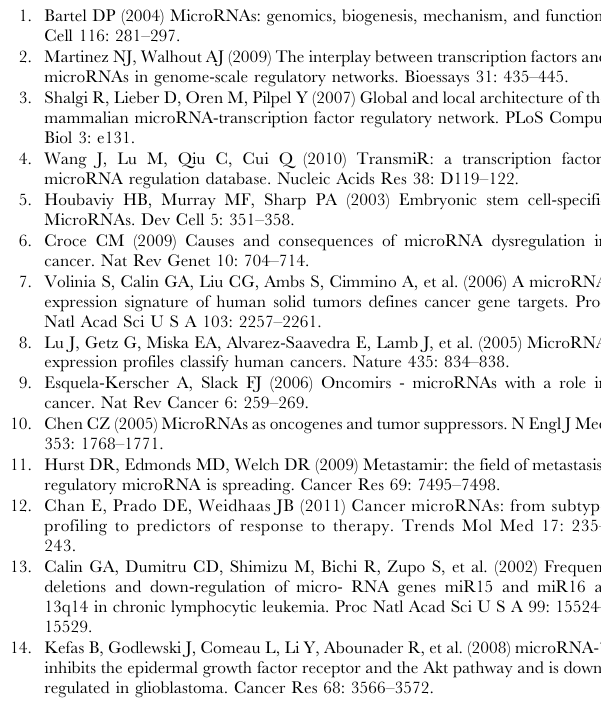
Values are indicated in parentheses. Furthermore, we indicate if a pathway is differentially expressed (DE) with FDR , 0.01. Table S3 Pairs of significantly associated miRs and pathways in ovarian cancer. 322 pathways that were significantly associated to miRs in ovarian cancer. Each pathway is annotated with its leading edge genes and important miRs. P- Values are indicated in parentheses Furthermore, we indicate if a pathway is differentially expressed (DE) with FDR , 0.01). Table S4 Pairs of significantly associated miRs and pathways in breast cancer. 309 pathways that were significantly associated to miRs in breast cancer. Each pathway is annotated with its leading edge genes and important miRs. P- Values are indicated in parentheses. Furthermore, we indicate if a pathway is differentially expressed (DE) with FDR , 0.01. Table S5 Pairs of miR/pathways that appear in all cancer types. We show 98 pairs between 59 pathways and 27 miRs that appeared in GBMs, ovarian and breast cancers. Table S6 Significantly associated miRs in glioblastoma, ovarian and breast cancers. In particular, we sorted miRs according to the number of significatly associated pathways (N pw ) and annotaed each miR if they appear in a set of literature-curated cancer miRs (C), are differentially expressed (E) and implicated in the corresponding cancer type